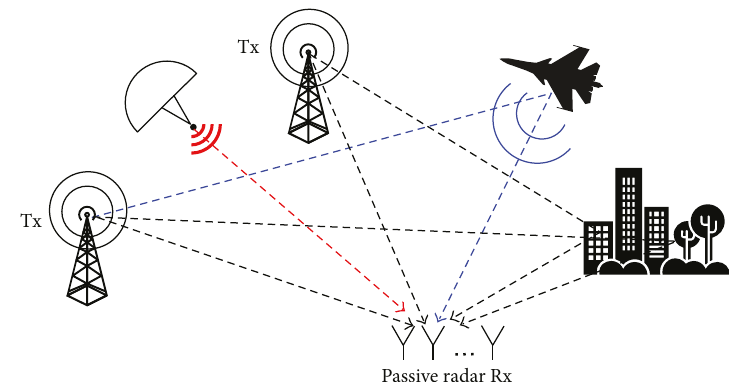
Figure 1: Signal model of the passive radar scenario.